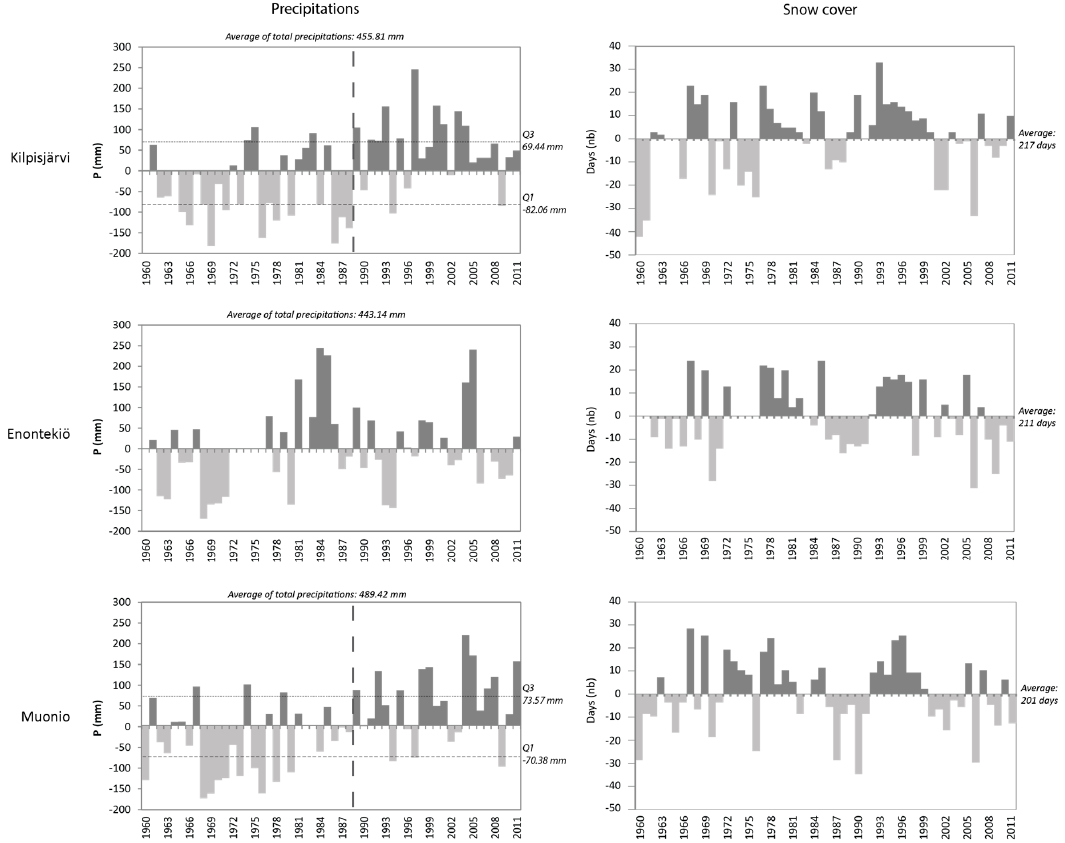
Figure 5. Annual anomaly of the total precipitation (mm) and permanent snow cover >1 cm (number of days) at Kilpisjärvi, Enontekiö and Muonio, 1960–2011. The shift point is shown as vertical dashed line.